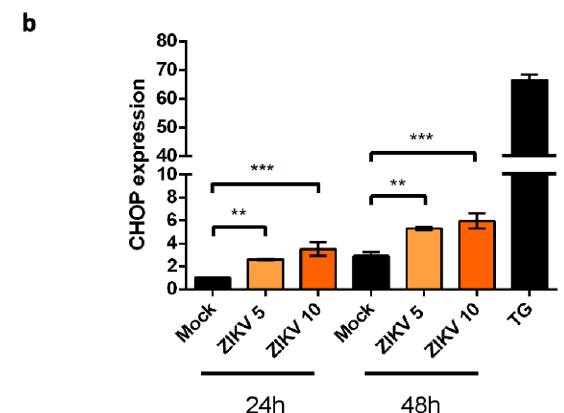
Figure 2. UPR inducible Transcription Factors, ATF4 and Xbp-1(s) are up-regulated in A549 cells infected with ZIKV. ( a ) Cells were infected with ZIKV at MOI = 5 for 24 h or treated with TG for 4 h. Cells were immunostained for ZIKV envelope (ZIKV-E, red) and ATF4 protein (green). Nuclei were stained with DAPI (blue). ( b ) RT-PCR of total Xbp-1 (spliced and unspliced) was performed in A549 cells infected with ZIKV at MOI 1, 5 or 10 for 24 h and 5 and 10 for 48 h post infection. Products were migrated on 2.0% agarose gel and compared to the one obtained in mock-infected cells and in cells treated with TG, the ER stress/UPR pharmacological inducer. ( c ) qRT-PCR analysis of Xbp-1(s) mRNA was performed in A549 cells infected or not with ZIKV at MOI 10 for different times as indicated. Our positive control cells have been treated with TG for 6 h. Data were presented as mean SEM ( n = 3). *** p < 0.001, ** p < 0.01, vs. mock.